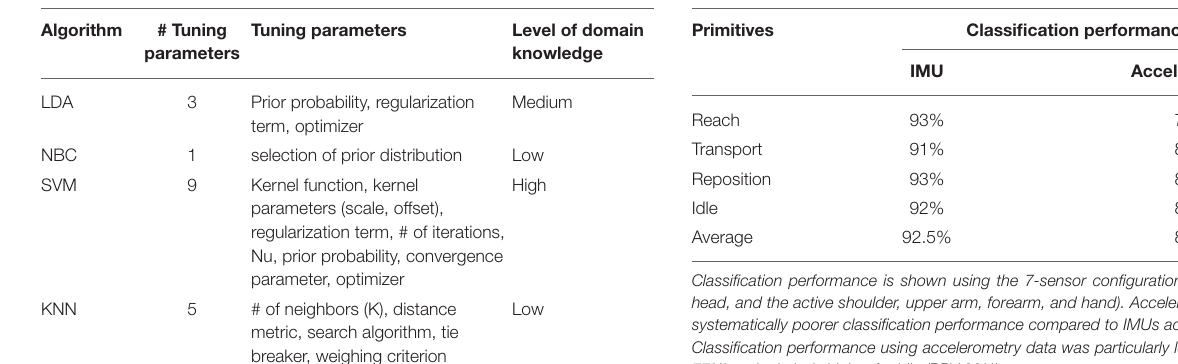
TABLE 4 | Primitive-level classification using IMU or accelerometer